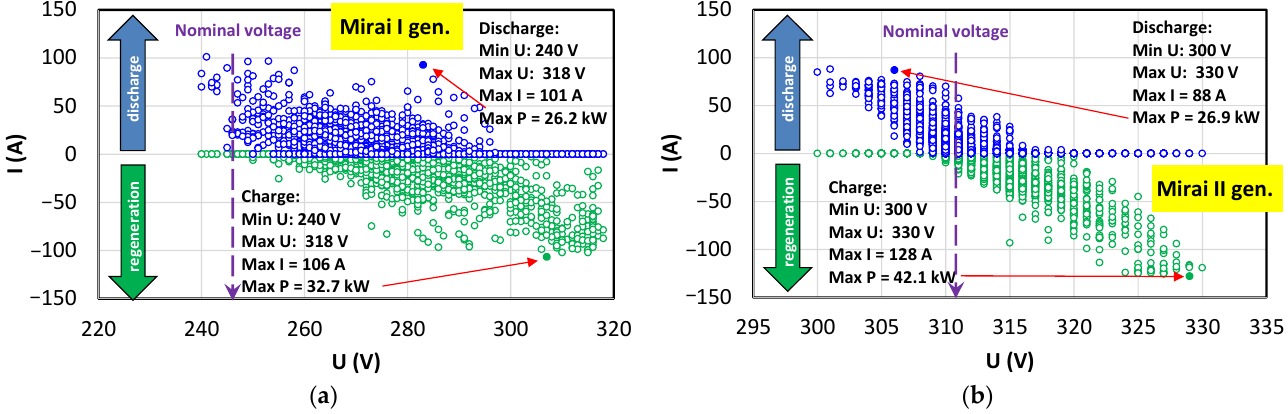
Figure 9. Battery charging and discharging characteristics: ( a ) for the first-generation Toyota Mirai; ( b ) for the second-generation Toyota Mirai.